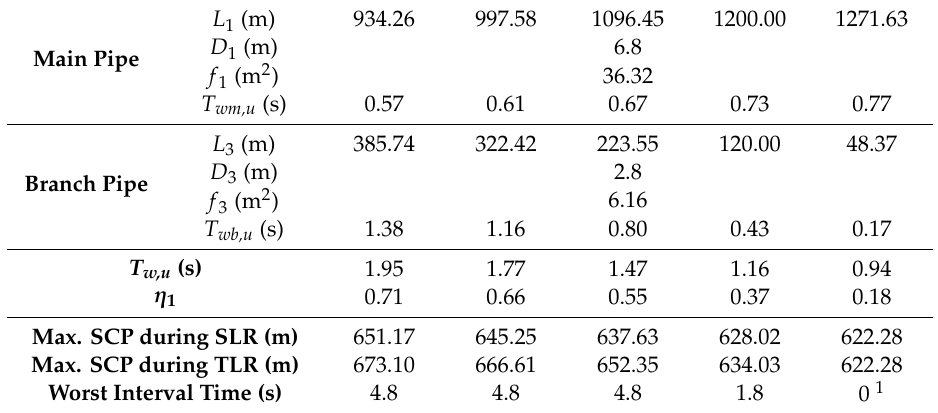
Table 2. Conduits parameters and corresponding results for Scenario